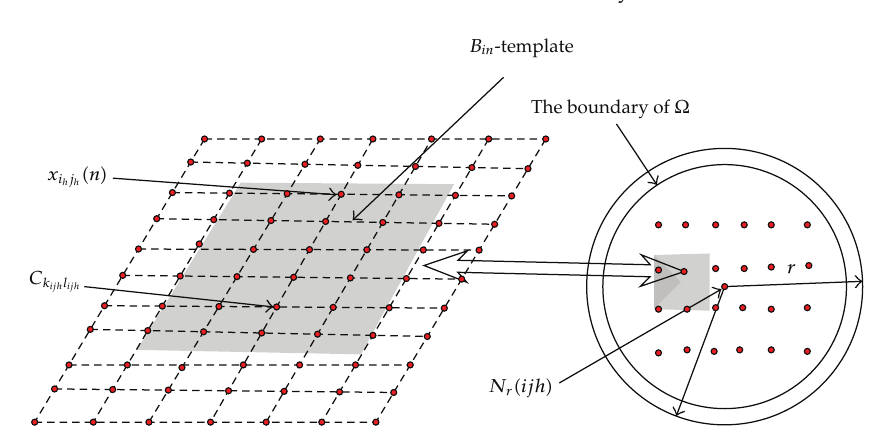
Figure 2: Input B -template and the boundary of Ω